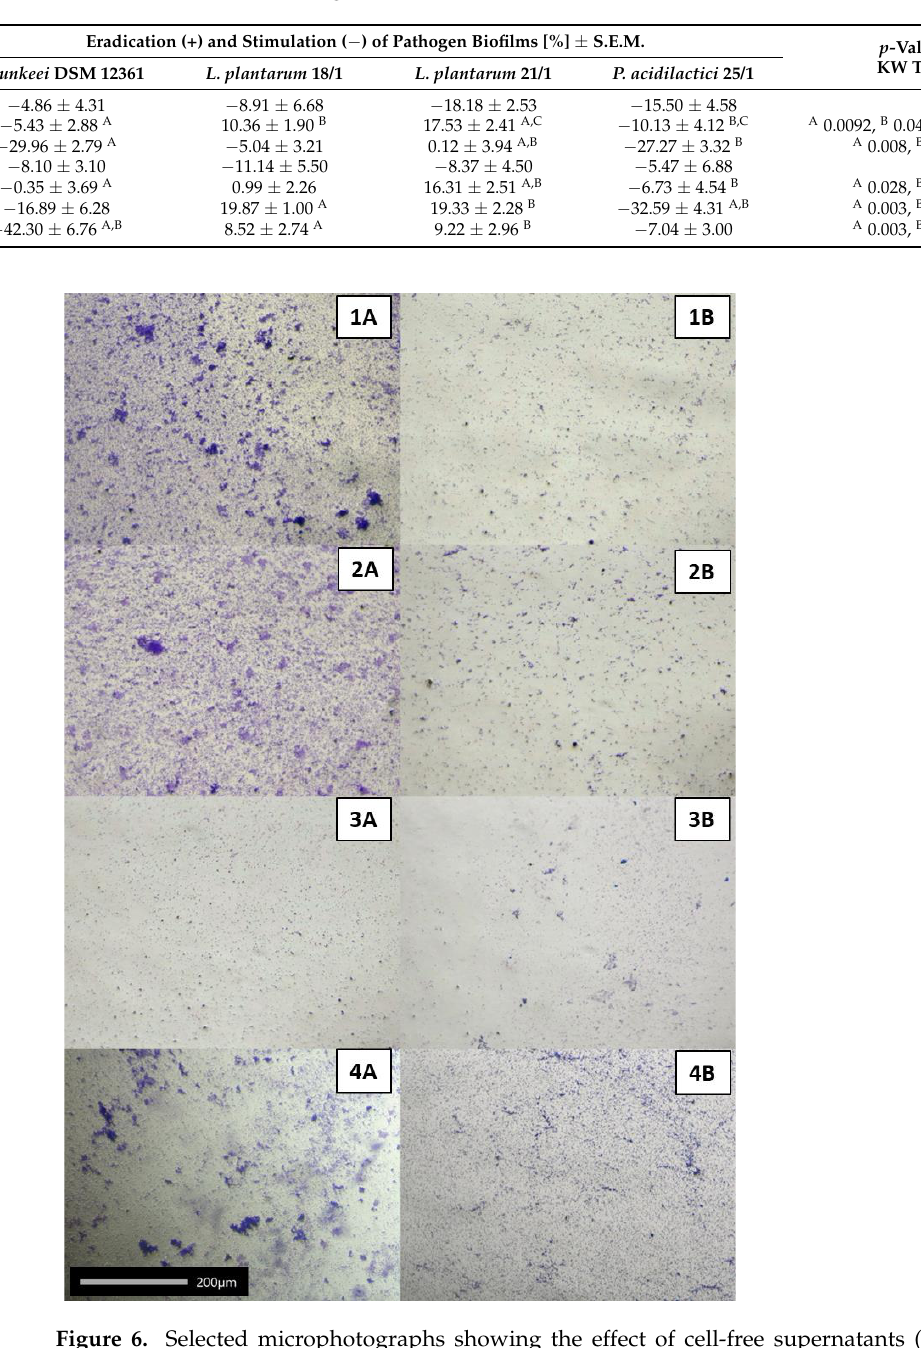
Table 3. Eradication (+) and stimulation ( − ) of pathogen biofilms [%] by cell-free supernatants (CFSs) from lactic acid bacteria (LAB) after 24 h incubation. Letters A, B and C indicate the pairs of CFS for which the eradication properties of pathogen biofilms were significantly different. The presented results are the mean from eight individual wells ± standard error of the mean (S.E.M.).